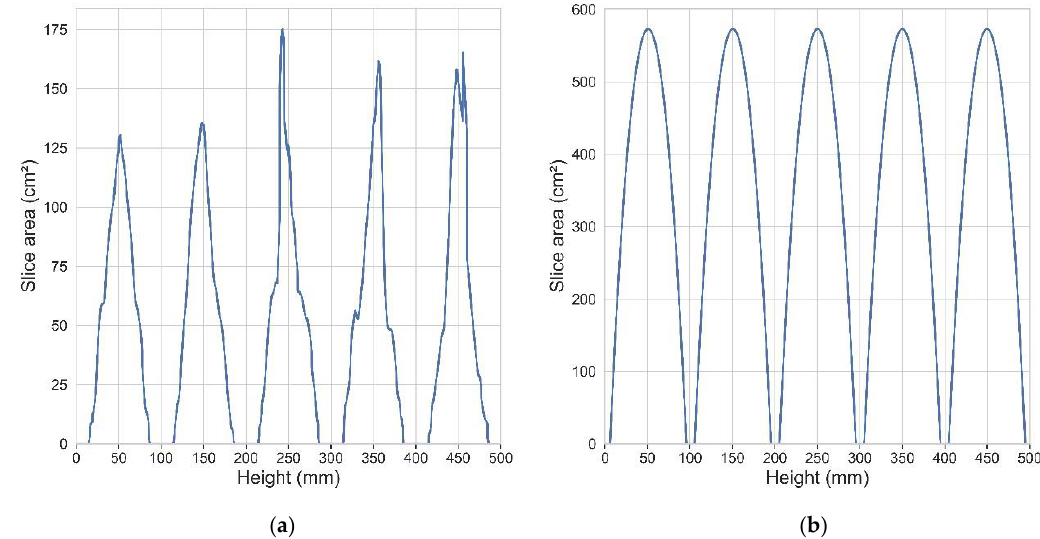
Figure 6. Slice distribution graphs showing the sintered area per layer. ( a ) Slice distribution for build 1 without additional specimens; ( b ) slice distribution for perfect spheres of 90 mm diameter in all positions.